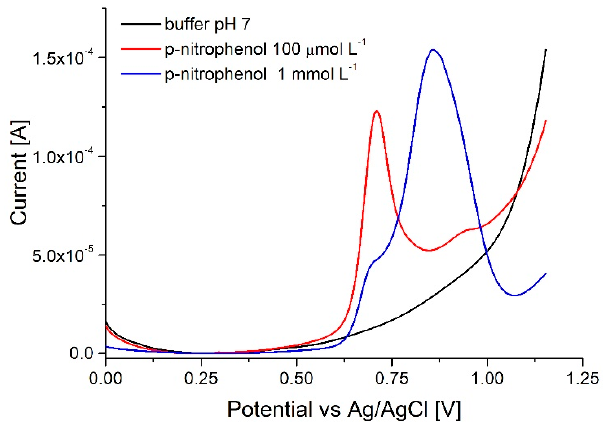
Figure 9. Two-step oxidation of p-nitrophenol on electrodes regenerated using NaOH oxidative cycling (the same method as tested for dopamine detection). Array of 16 posts, flow of 100 µL min − 1 .